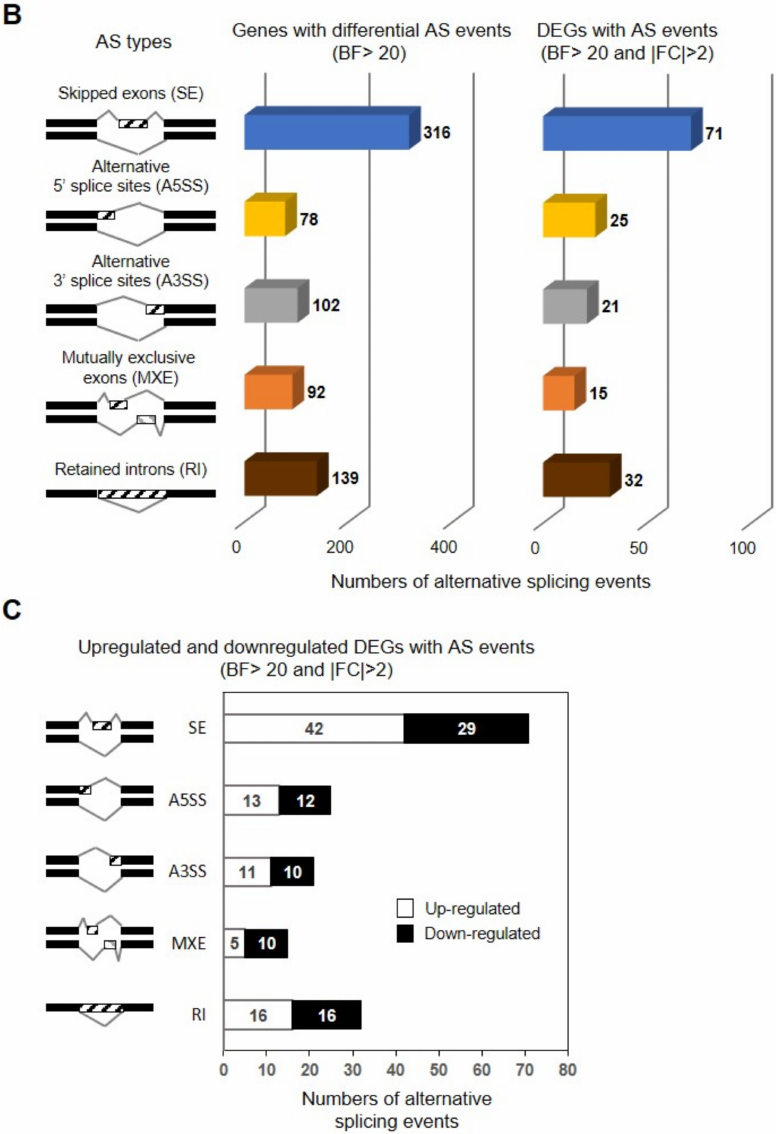
Figure 2. Comparative analysis of DSEs between iMSCs and UCB-MSCs. ( A ) Venn diagram showing the overlap of DEGs and DSEs detected by RNA-Seq in a comparison of iMSCs versus UCB-MSCs. AS events with BF > 20 were used for further analysis. ( B ) The number of DEGs with indicated AS events. ( C ) The number of upregulated and downregulated DEGs with indicated AS events. The x-axis represents the number of transcripts for each type of AS events. The y-axis represents five types of AS events, including SE, MXE, A5SS, A3SS, and